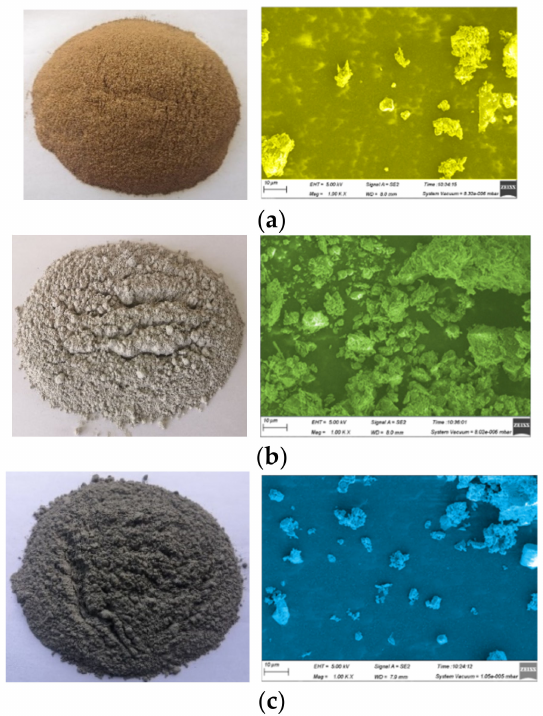
Figure 5. Raw material samples and micrograms: ( a ) clay materials and microgram; ( b ) stone powder and microgram; ( c ) cement and microgram.